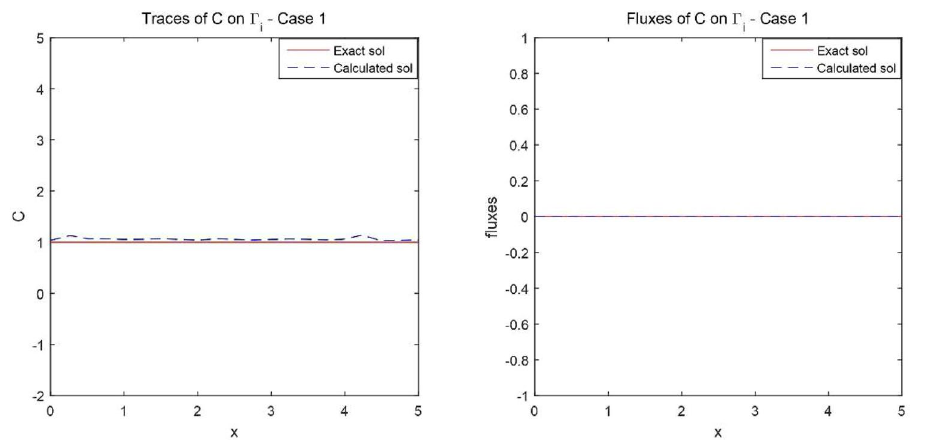
Figure 3. The reconstructed concentration—Case